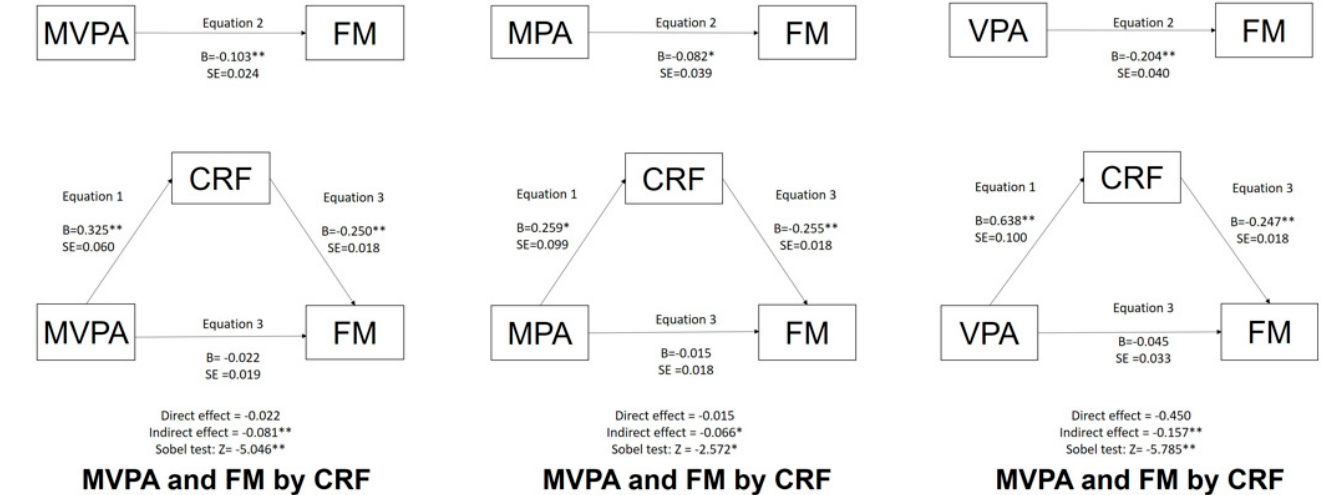
Figure 2. Mediation of MVPA/MPA/VPA and FM by CRF for adolescents. Legend: ** p ˂ 0.001; * p < 0.05; MVPA = moderate to vigorous physical activity; MPA = moderate physical activity; VPA = vigorous physical activity; CRF = cardiorespiratory fitness; FM = fat mass.